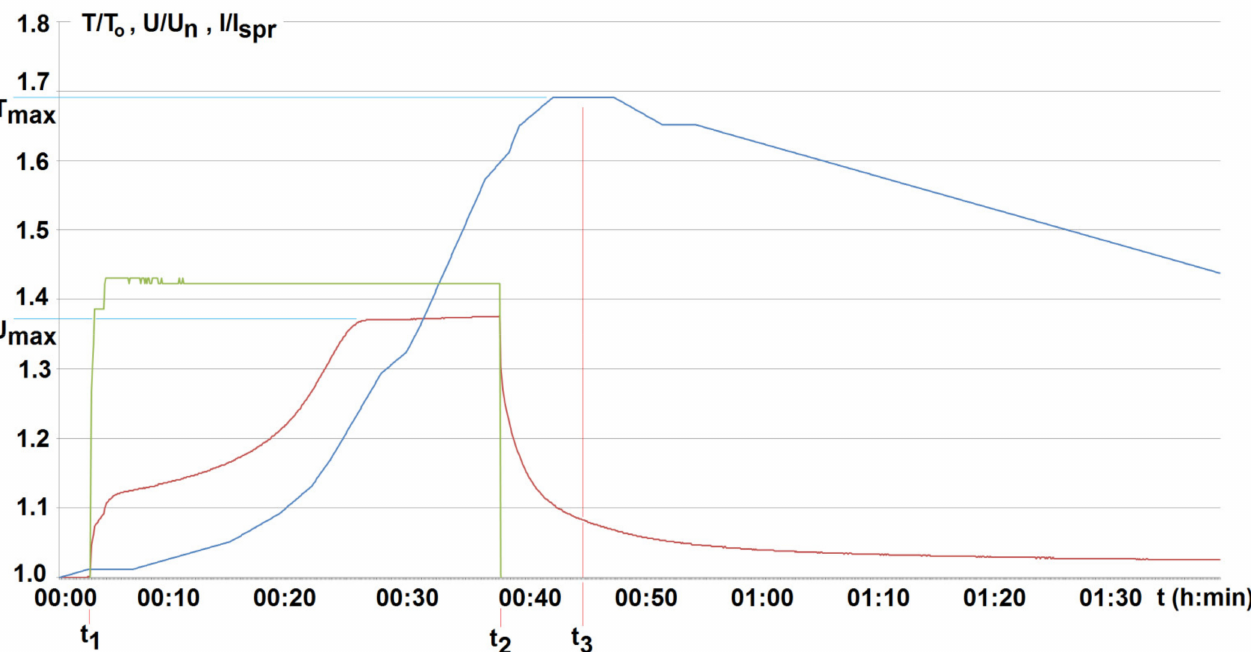
Figure 7. The temperature (T1 sensor-blue line), load current (green line, I spr is a standard discharge current equal to 10 A), and cell (LiFePO 4 ) voltage U/U n (red line) variation as a function of time during the overcharging (voltage U max over 37%) (rated U n = 3.2 V, ambient temperature T 0 = 22 ◦ C, t 1 , t 2 —time of switching the charger on and off, t 3 —time of the maximum temperature T max = 37 ◦